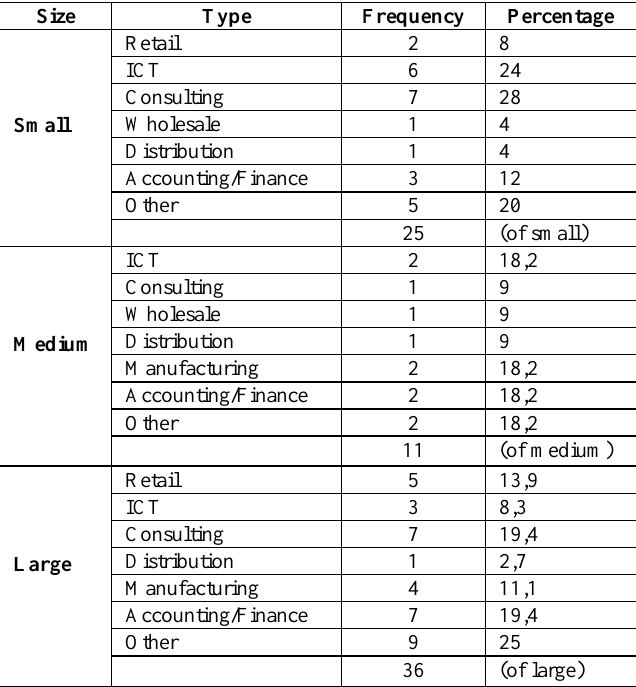
Table 2: Frequency of